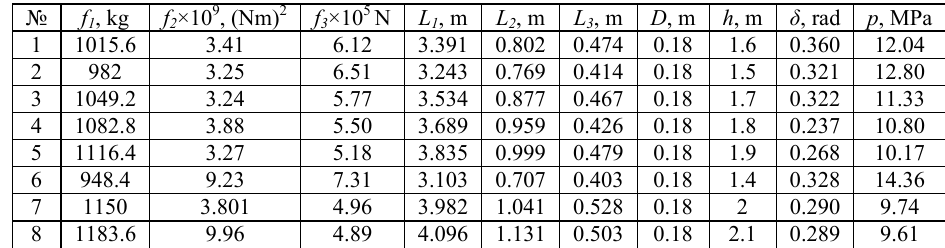
Table 5. Pareto optimal solutions - Stage II